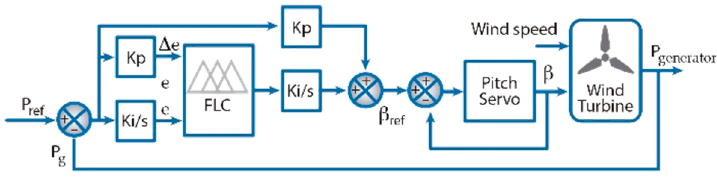
Figure 11. Controllers of the hierarchical type, PI-Fuzzy-PI [57].